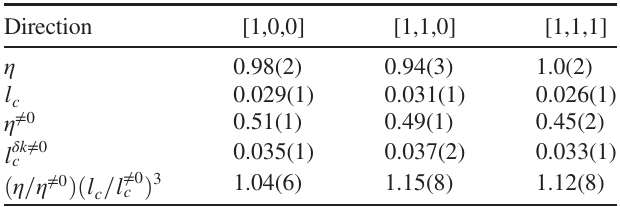
TABLE II. Results from fitting the bunching peaks in g ð 2 Þ ð δ k Þ are, respectively, the amplitude and the with a Gaussian. η and l c correlation length of the bunching at δ k ¼ 0 . η ≠ 0 and l ≠ 0 c are, respectively, the amplitude and the correlation length of the bunching at δ k ≠ 0 . The ratio of the 3D integral of the bunching peaks at δ k ¼ 0 and at δ k ≠ 0 is close to 1 along any direction of the reciprocal